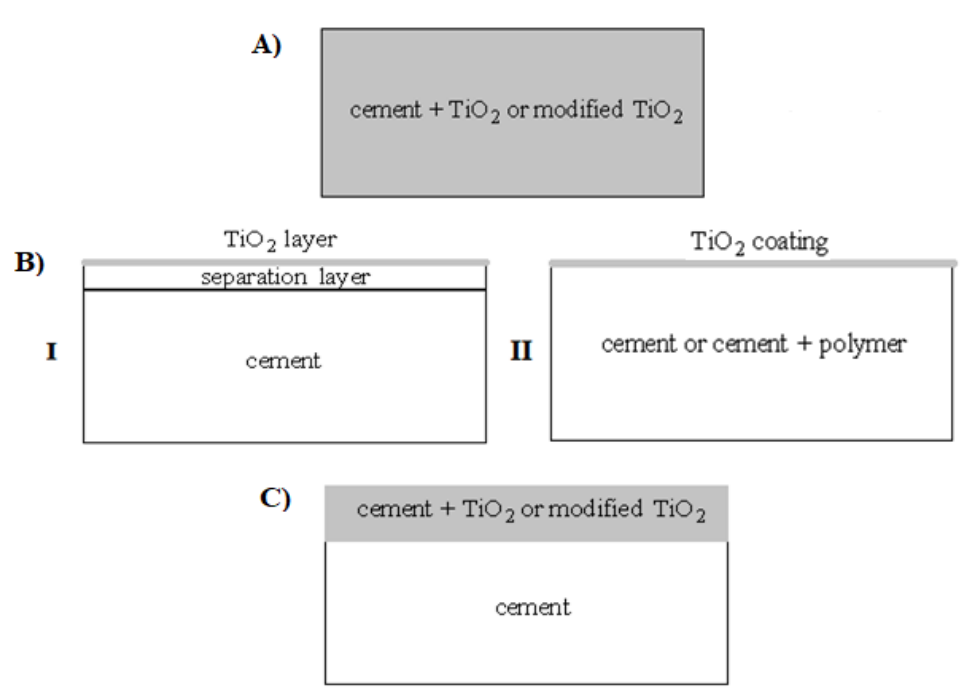
Figure 1. Scheme of possible methods of cement modification by photocatalysis: ( A ) incorporation method, ( B ) surface treatment method: with (I) and without (II) a separation layer, ( C ) surface coating with a composite cement surface layer containing the photocatalyst